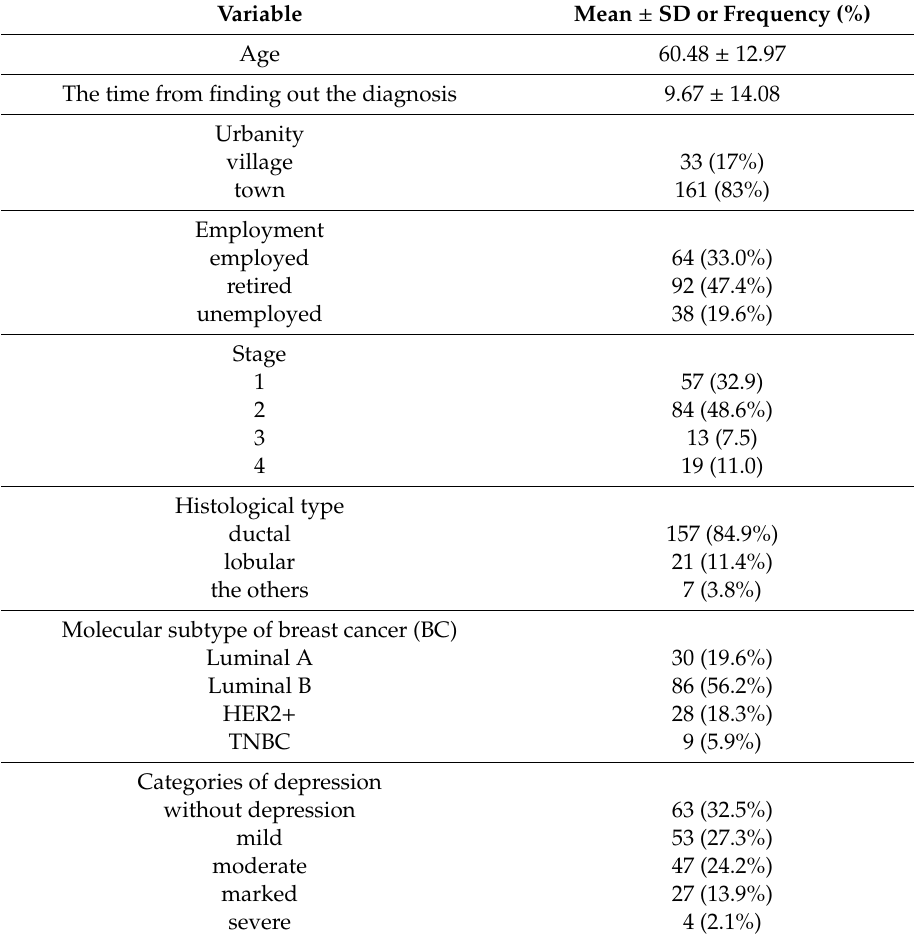
Table 1. General characteristics of female